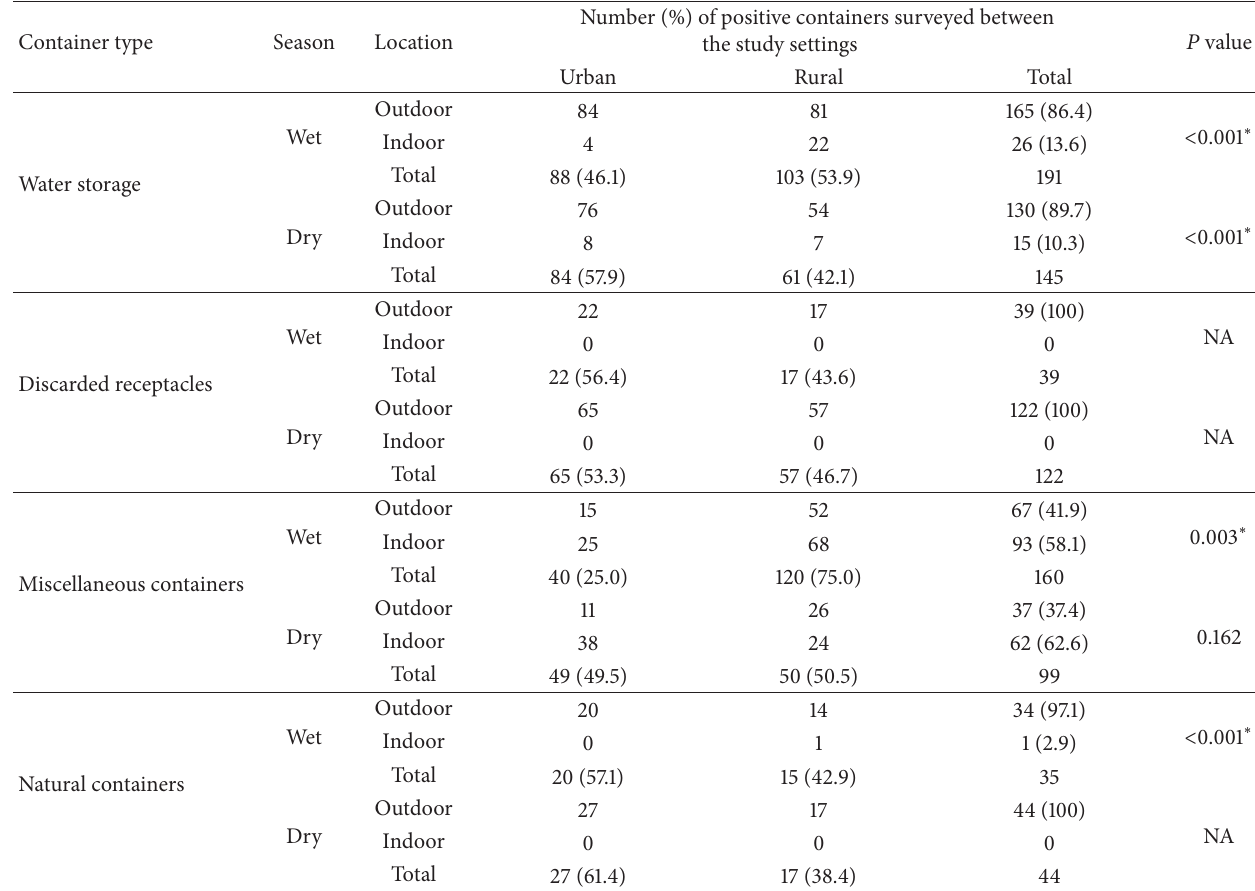
Table 2: Seasonal and geographical distributions of Aedes vectors in water-holding